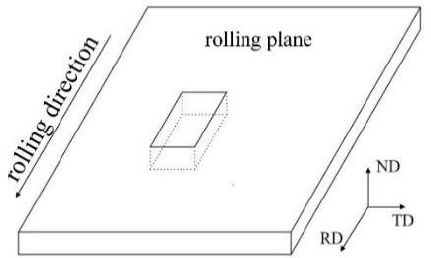
the experimental parameters.